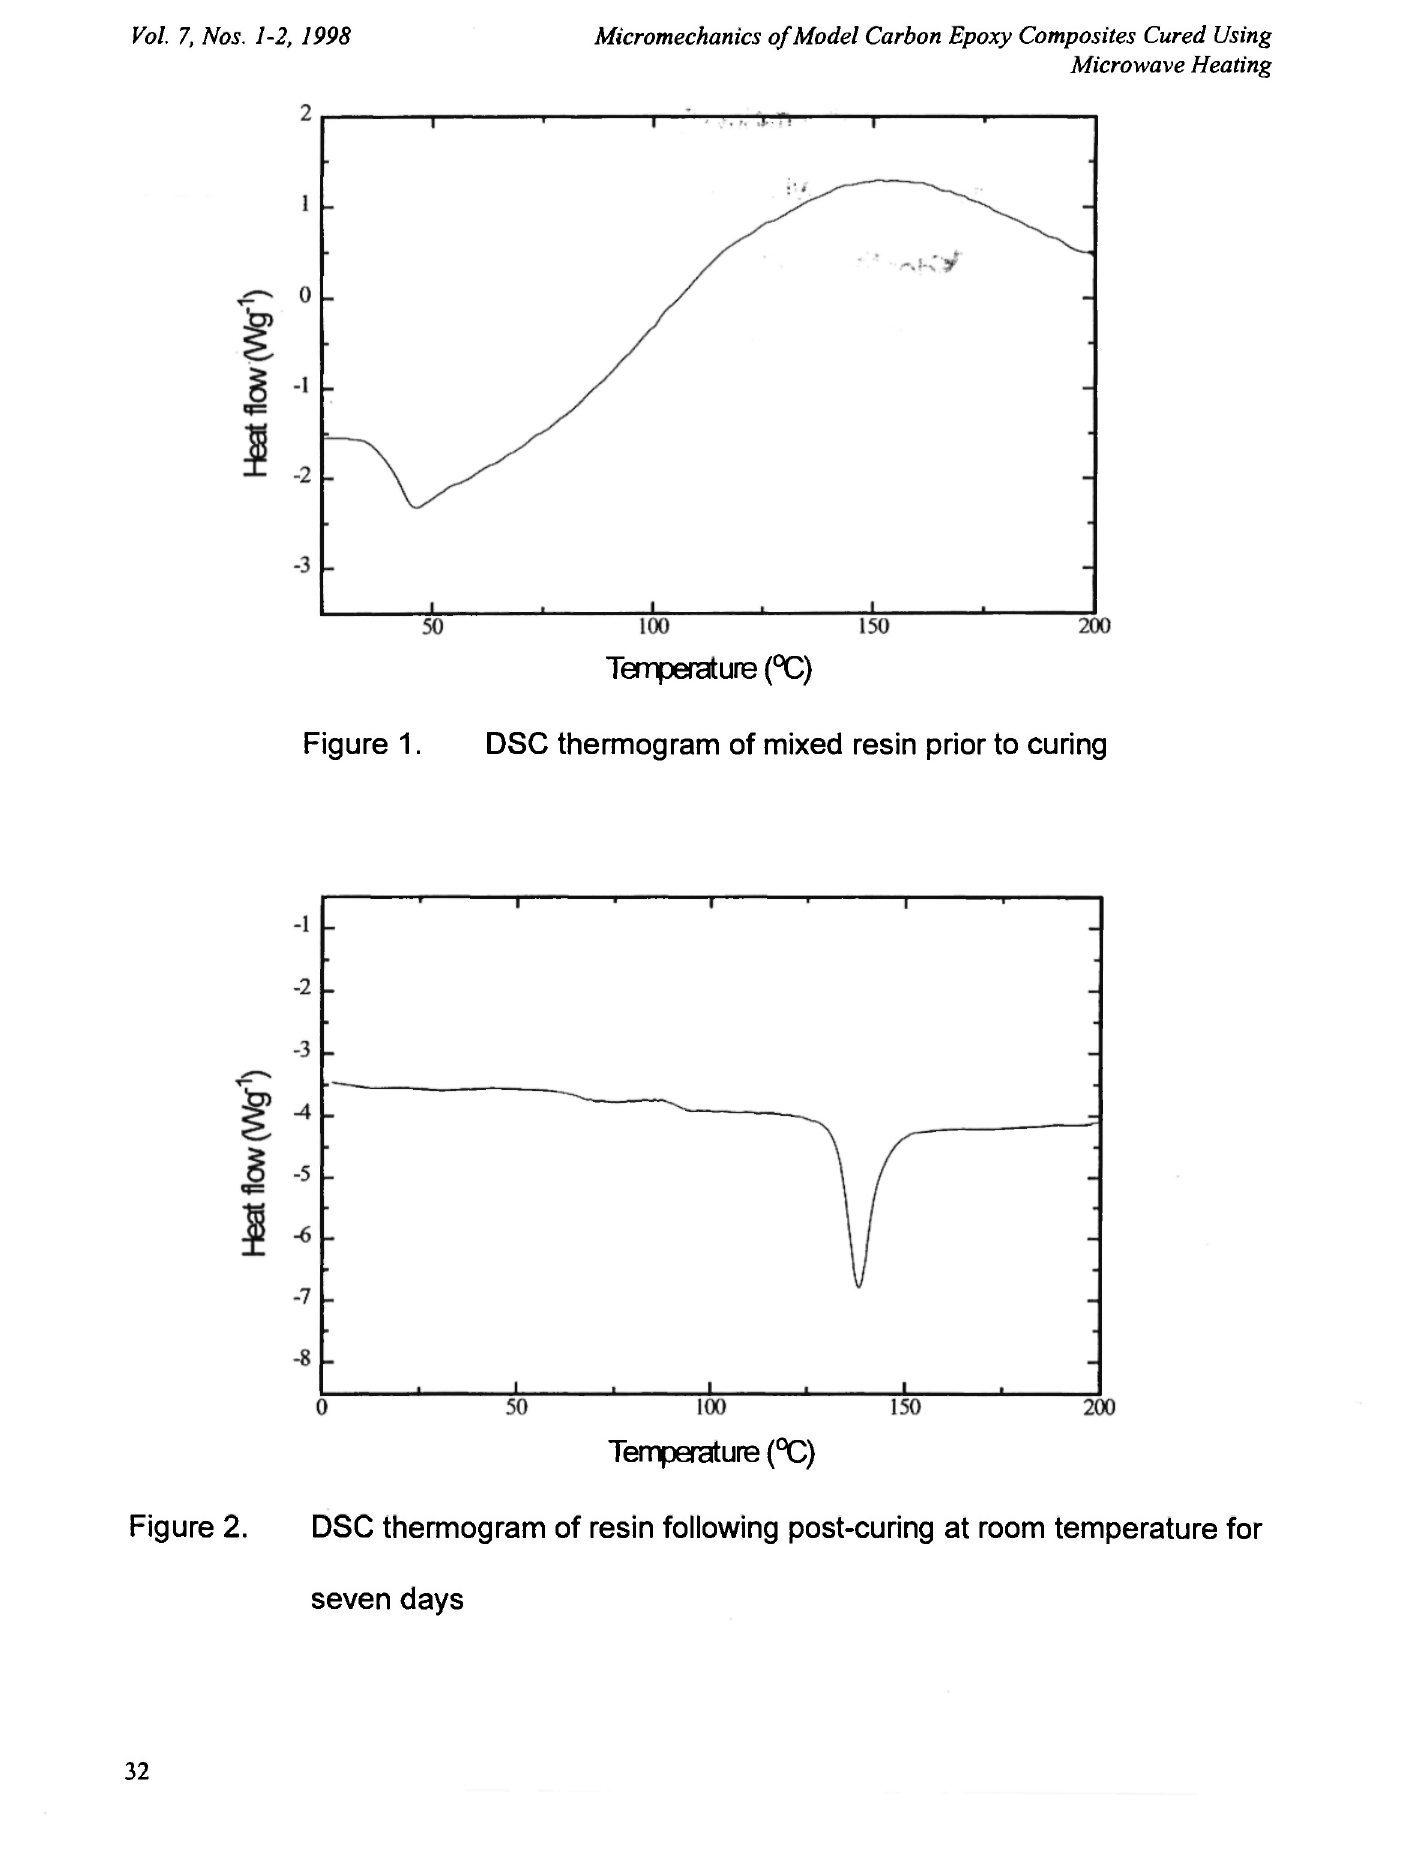
Figure 2. DSC thermogram of resin following post-curing at room temperature for seven